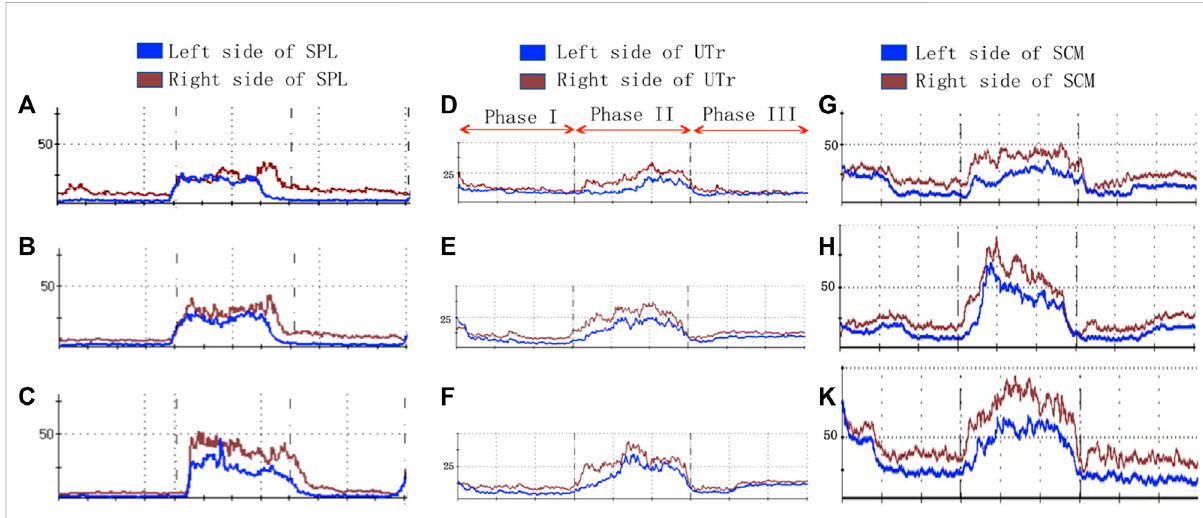
FIGURE 4 SEMG-based myoelectricalactivitiesofthecervicalrotatorsunderthedifferentHRpatterns. (A – C) ,noHR; (D – E) ,unilateralHR; (G – K) ,bilateral HR; Phase I, resting phase; Phase II, rotating phase; Phase III, returning phase.